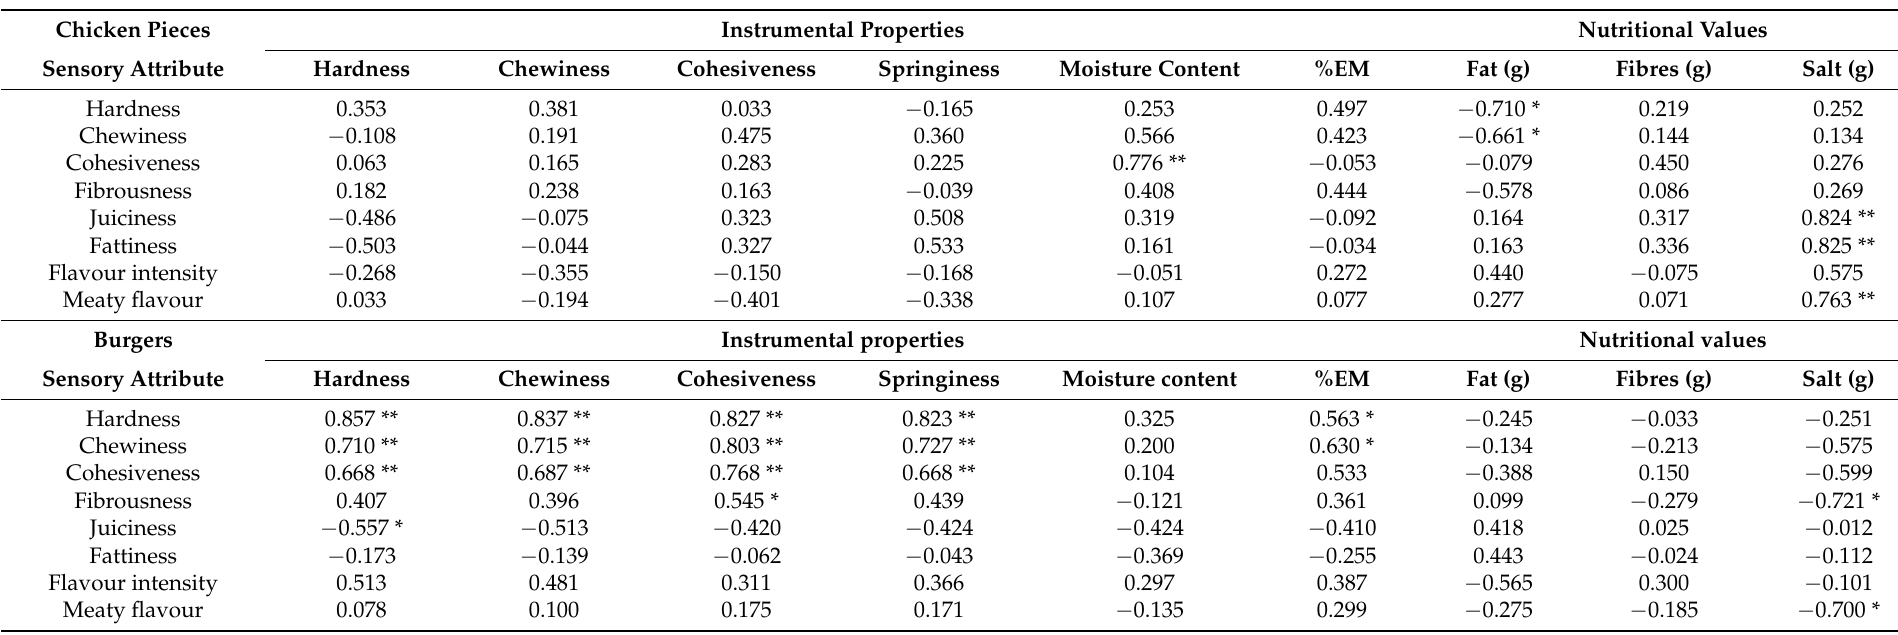
Table 7. Pearson correlation coefficients (r) between average sensory attributes, instrumental properties, and compositional